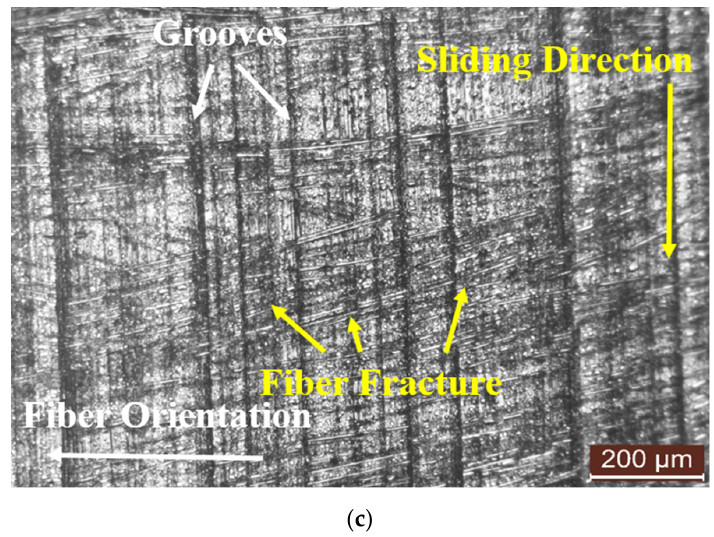
Figure 5. Optical micrograph of wear surfaces at 50 N load with different fiber orientation angles: ( a ) 0°, ( b ) 45°, and ( c ) 90°.